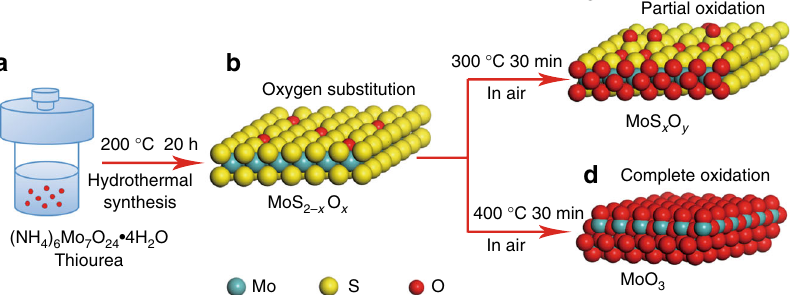
Fig. 1 Structure and synthesis of oxygen-substituted and oxidized MoS 2 . Oxygen incorporation in MoS 2 has two fundamentally different types: substitution of oxygen for sulfur within MoS 2 lattices and partial oxidation of molybdenum atoms along edge planes or at defects of MoS 2 crystals. a , b Low- temperature hydrothermal treatment of (NH 4 ) 6 Mo 7 O 24 · 4H 2 O with the assistance of thiourea as an additive realizes oxygen substitution. c Annealing of MoS 2 sample at 300 °C for 30 min produces partially oxidized MoS 2 without changing its crystal structure. d Annealing of MoS 2 sample at 400 °C for 30 min makes MoS 2 completely oxidized to MoO 3 , which reshapes its